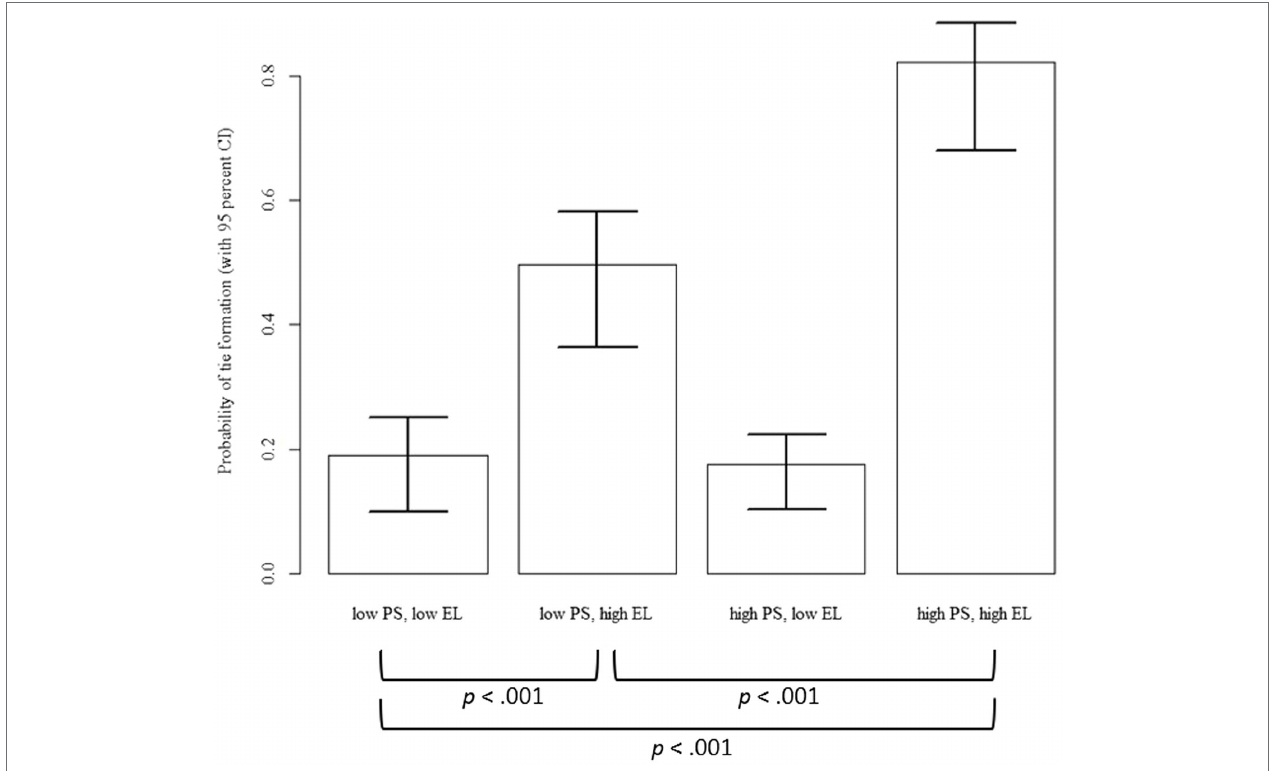
FIGURE 4 | Interaction plot between political skill (PS) and empowering leadership (EL) for being relied on for leadership (i.e., receiver